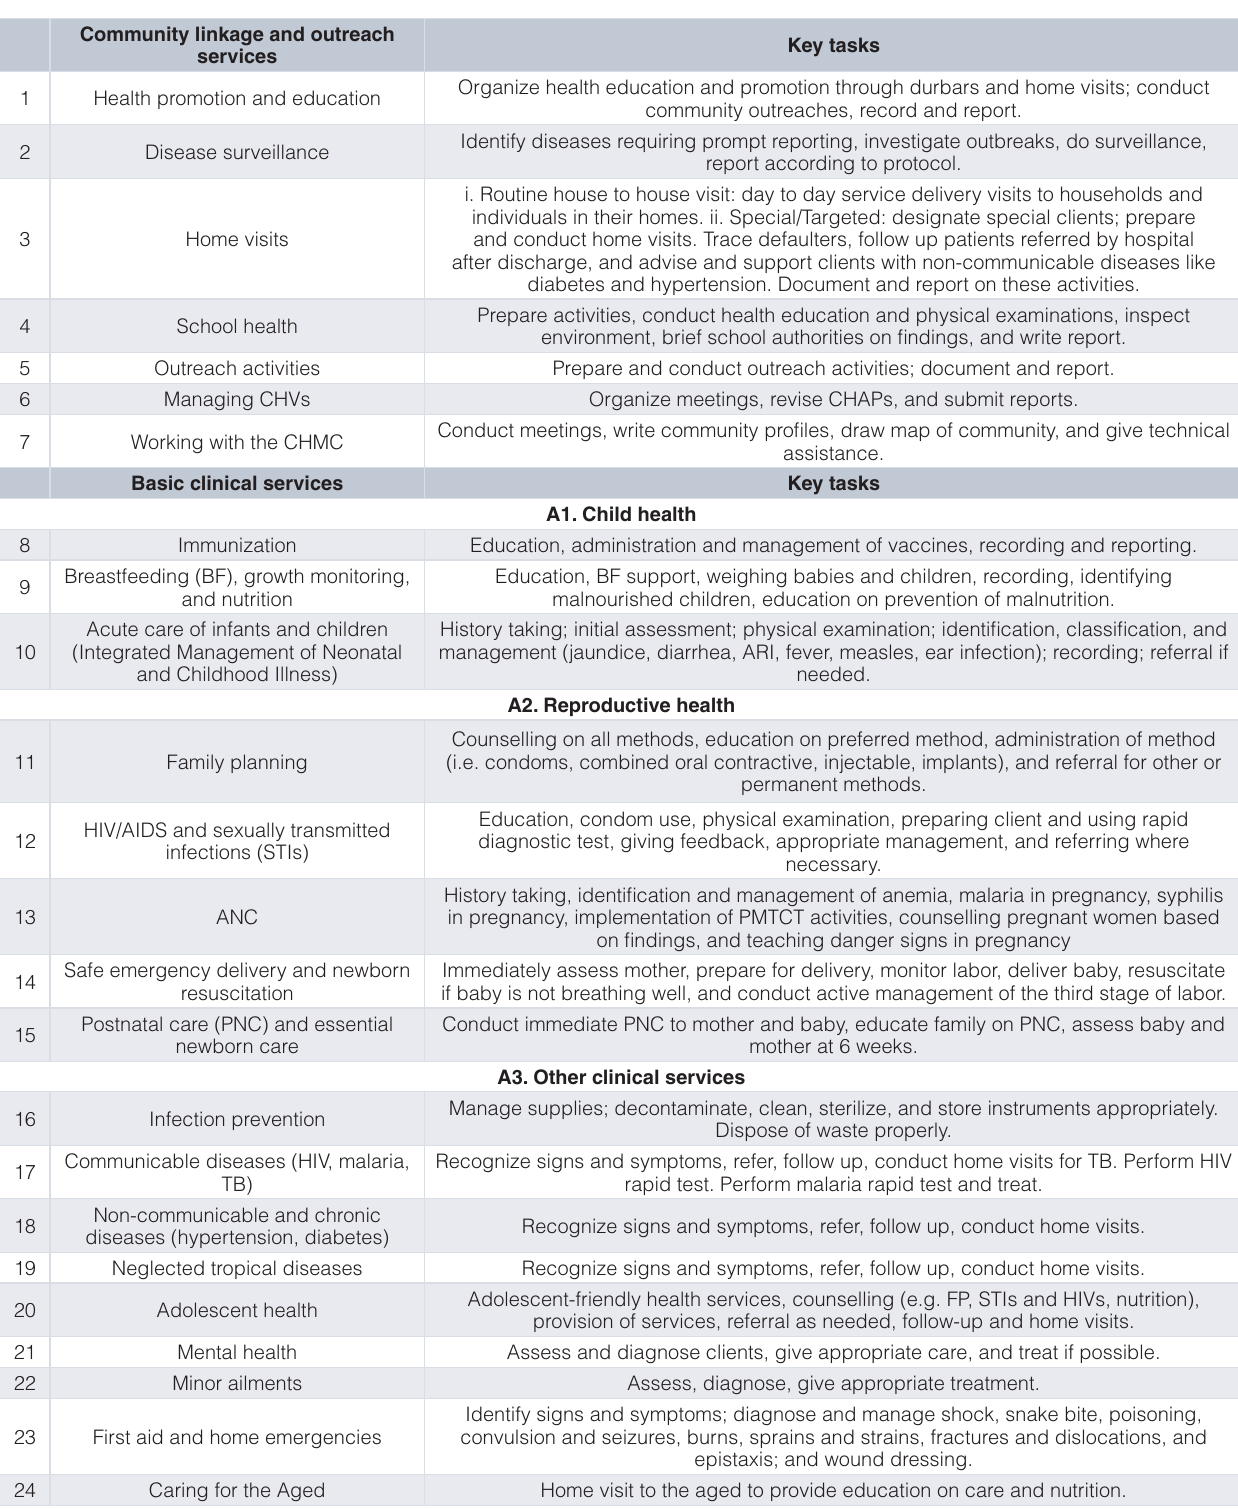
Table 1. Roles and responsibilities of Community Health Officers (CHOs) 8